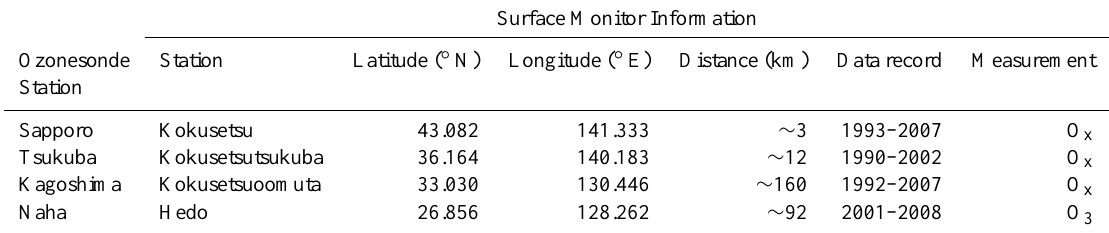
Fig. 6. Histograms of the offsets between mean ozonesonde profile data between the surface and 100m above the surface with hourly-average oxidant data from the nearest surface monitor available (station number/name in plot title) in the long-term database (www.nies.go.jp/igreen/ tddisp.html), both with and without the recommended CF applied. All stations show better agreement without the CFs applied. See also Table 6 for a statistical analysis.